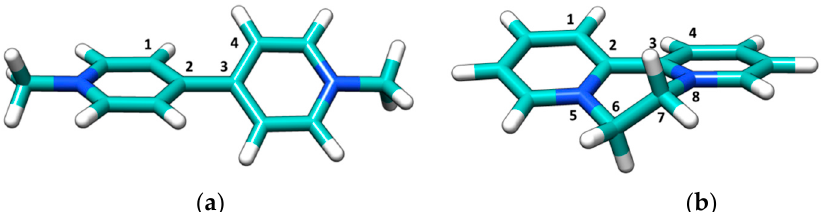
Figure 6. Density functional theory (DFT) optimized molecular structure of ( a ) PQ and ( b ) DQ.